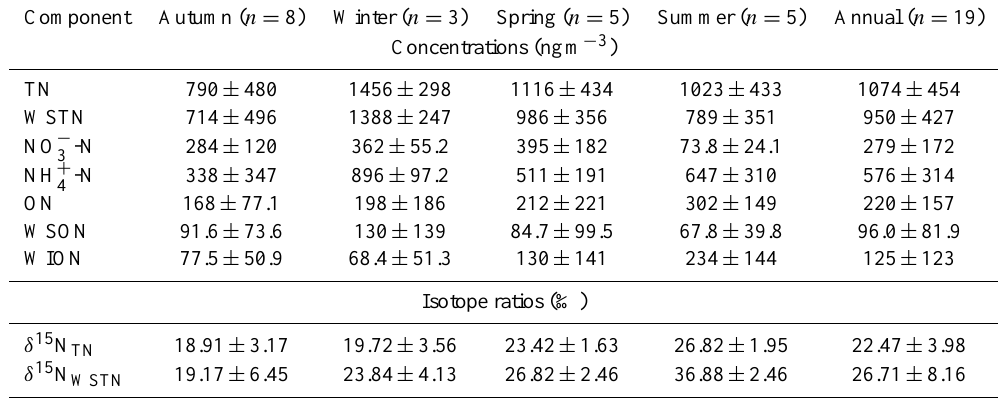
Table 1. Seasonal and annual averages with standard deviation of the concentrations of nitrogenous components and 15 N isotope ratios of TN and WSTN in atmospheric aerosol (TSP) samples collected from 2 September 2009 to 5 October 2010 in Sapporo, northern Japan.